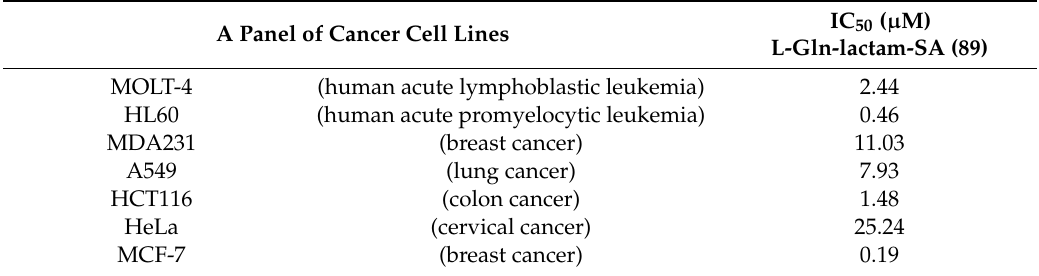
Table 2. Cytotoxicity of L-Gln-lactam-SA ( 89 ) against a panel of cancer cell lines. A Panel of Cancer Cell Lines